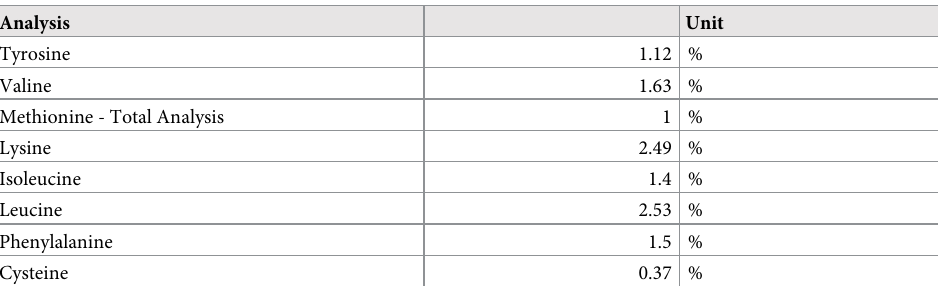
PLOS ONE | https://doi.org/10.1371/journal.pone.0235285 June 29,